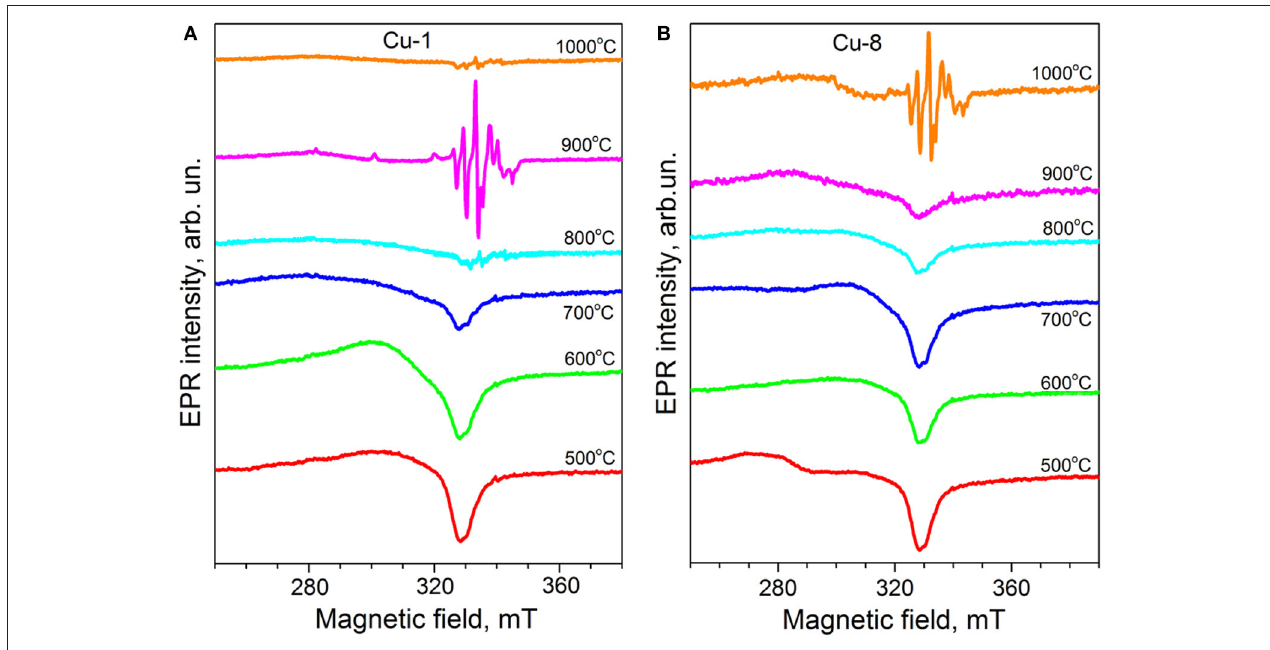
FIGURE 6 | EPR spectra of (A) Cu-1 and (B) Cu-8 samples calcined at 500–1,000 ◦